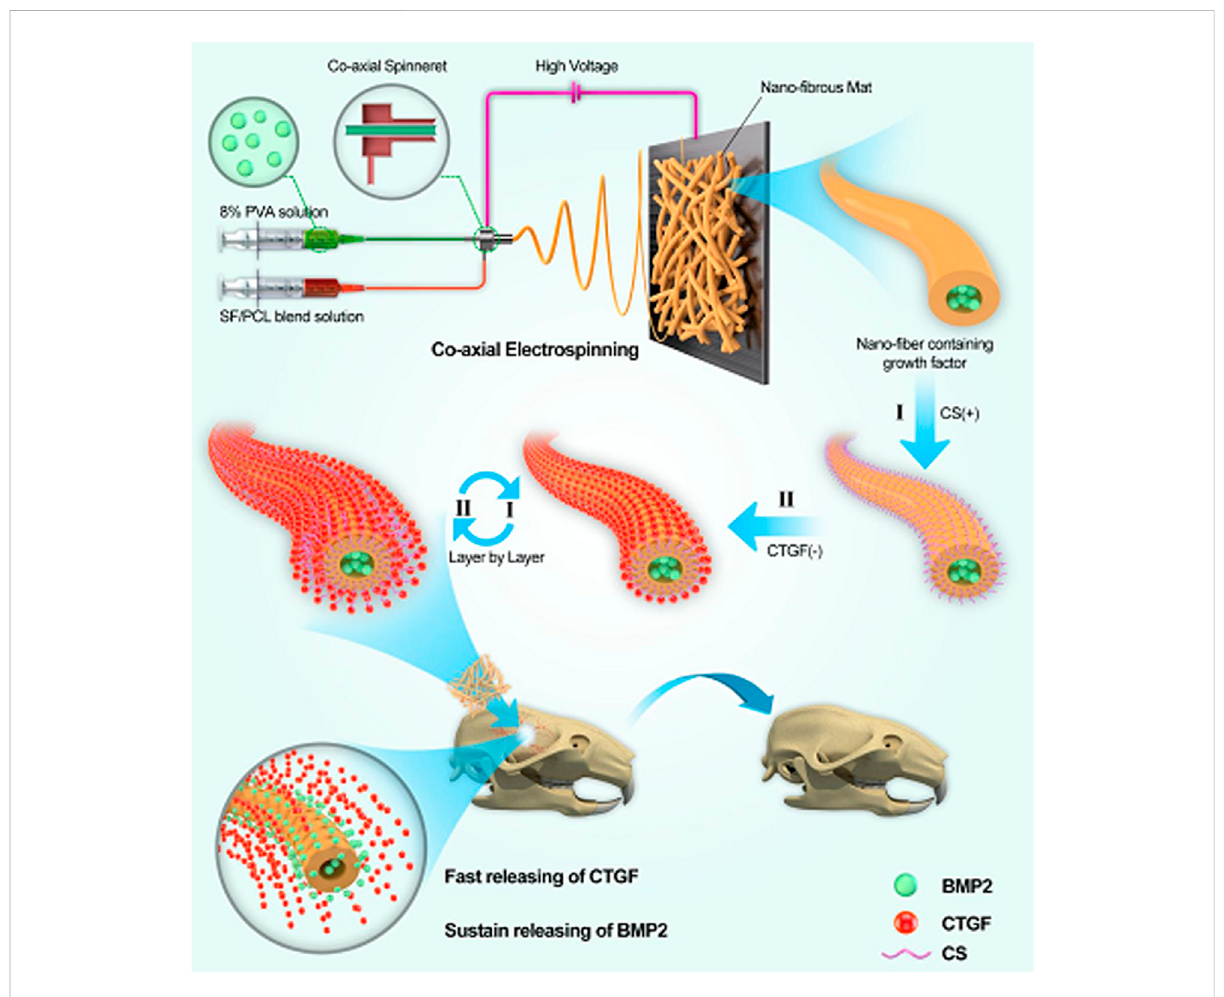
FIGURE 13 Schematic illustration showing the incorporation of BMP-2 and CTGF in the core-shell nano fi bers of SF/PCL/PVA mats used for bone tissue engineering. (Reproduced with permission from Ref. (Cheng et al., 2019). Copyright 2019, American Chemical Society).